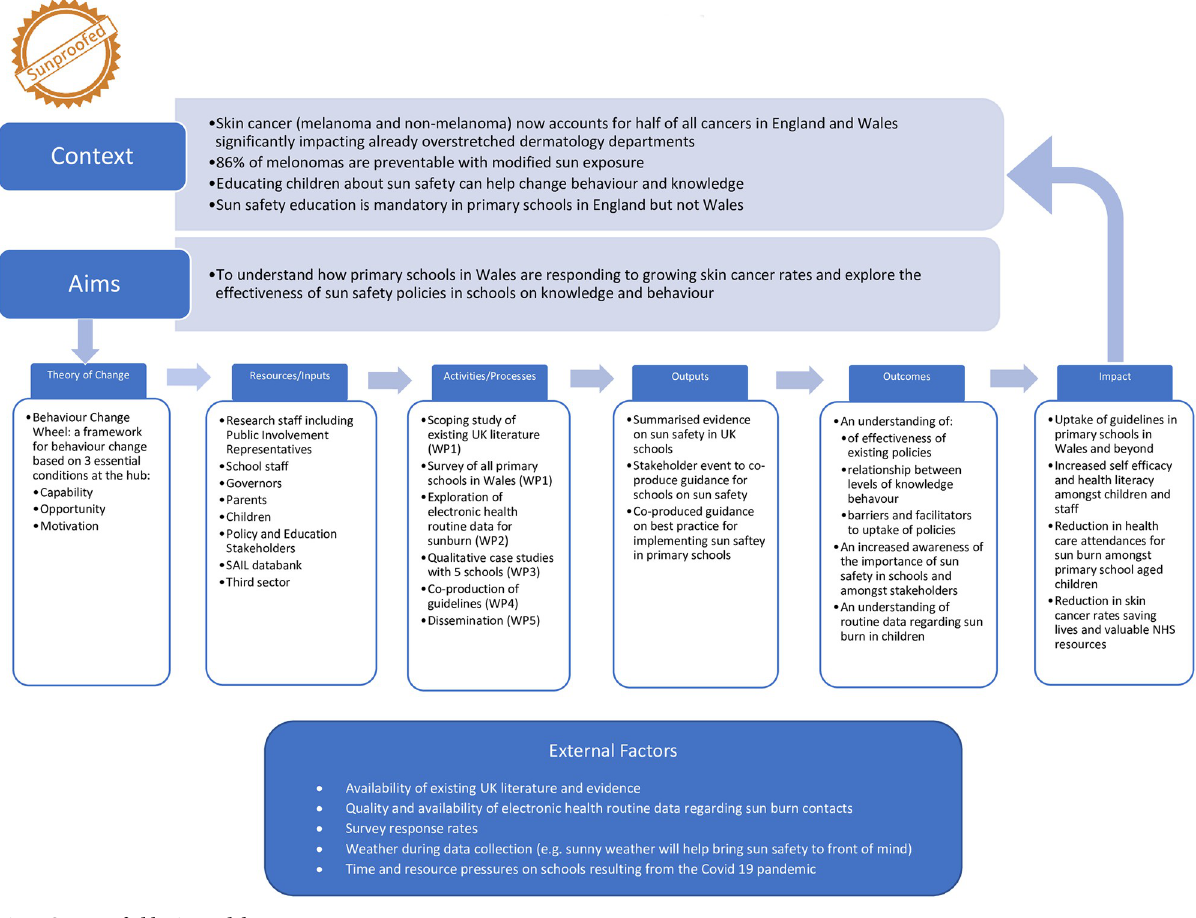
Fig 1. Sunproofed logic